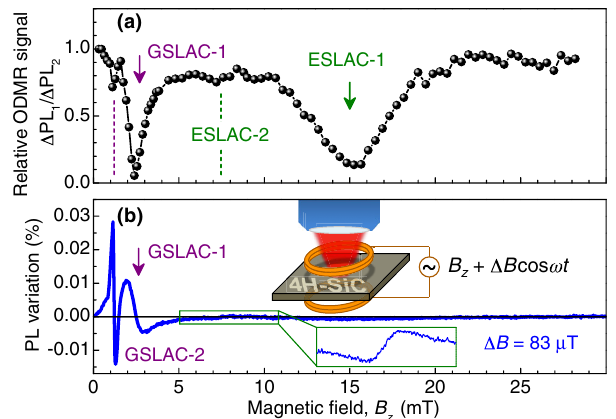
FIG. 2. (a) Relative strength of the ν 1 and ν 2 ODMR transitions ( Δ PL 1 = Δ PL 2 ) as a function of the magnetic field B applied parallel to the c axis of 4H-SiC. The arrows indicate the positions of GSLAC-1 (2.5 mT) and ESLAC-1 (15 mT). The vertical dashed lines correspond to the expected positions of GSLAC-2 (lower field) and ESLAC-2 (higher field). (b) Lock-in detection of the PL variation Δ PL = PL as a function of the dc magnetic field B , where Δ PL is caused by the application of an additional weak z Δ B cos ω t with Δ B ¼ oscillating magnetic field Δ B ; i.e., B z þ 83 μ T and ω = 2 π ¼ 5 kHz. The sharp resonancelike signal at 1.25 mT corresponds to GSLAC-2. Resonant rf field is not applied. Upper inset: A scheme of the experiment. Lower inset: A detailed measurement in the magnetic field range corresponding to